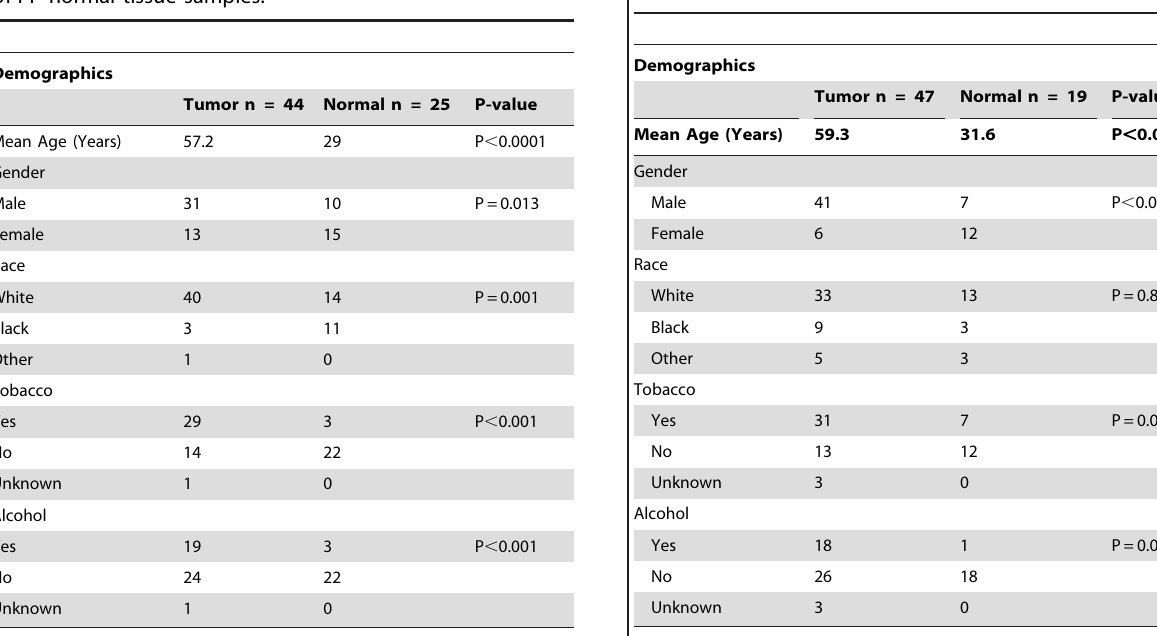
Table 3. Demographic characteristics of validation tumor and UPPP normal tissue